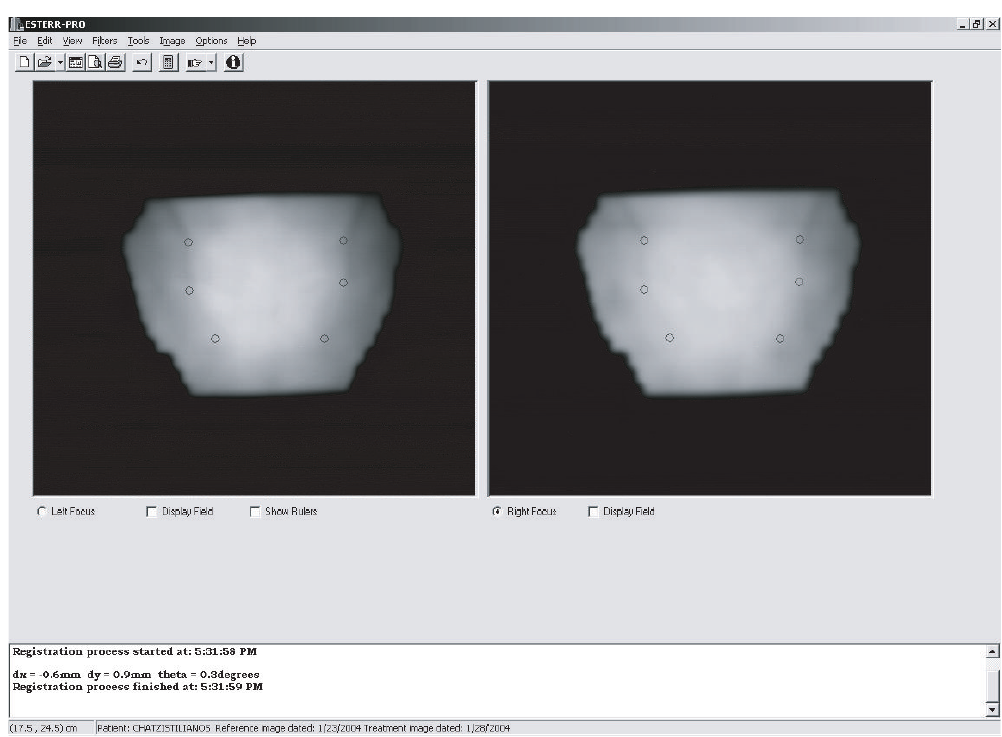
Figure 4: Example of matching a pair of portal images on patient data. The fiducial marks, defined by the user, are shown on the reference image (left panel). The corresponding points on the other portal image, after the end of matching procedure, are also